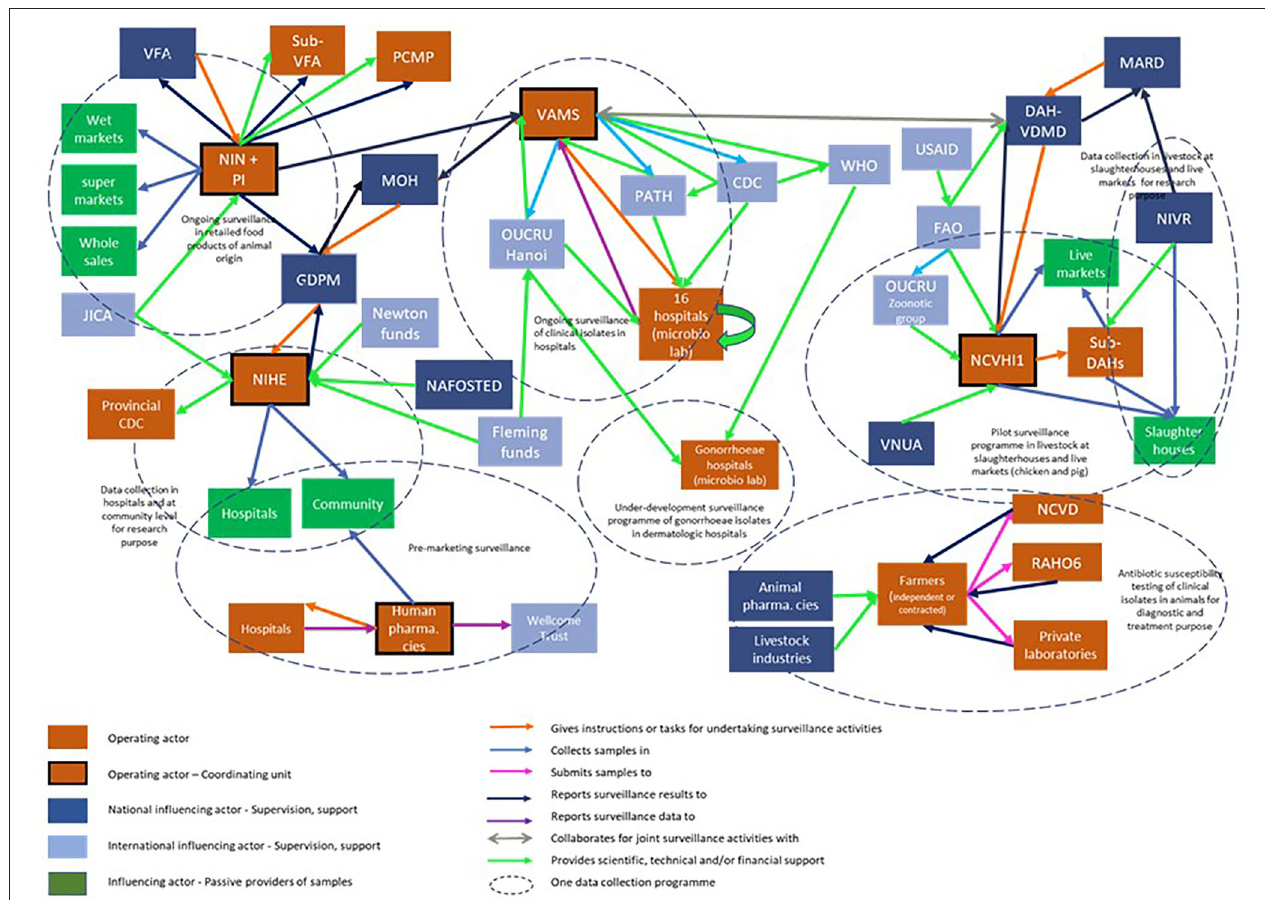
FIGURE 5 | Stakeholder diagram for the surveillance system of antimicrobial resistance in Vietnam. CDC, center for disease control; DAH, department of animal health; FAO, Food and agriculture organization; GDPM, General department of preventive medicine; JICA, Japanese international cooperation agency; MARD, Ministry of agriculture and rural development; MOH, Ministry of Health; NAFOSTED, National Foundation for Science and Technology Development; NCVD, National center for veterinary diseases; NIHE, National institute of hygiene and disease control and prevention; VAMS, Vietnam administration of medical services; VFA, Vietnam food administration; VNUA, Vietnam National University of Agriculture; NCVHI1, National center for veterinary hygiene 1; NIN, National institute of nutrition; NIVR, National institute of veterinary research; WHO, World health organization; OUCRU, Oxford University Clinical Research Unit; PATH-CDC, PATH program of the United States Center for disease control and prevention; PI, Pasteur institutes; RAHO6, Regional animal health organization 6; USAID, United States agency for international development; US-CDC, United Stator Center for disease